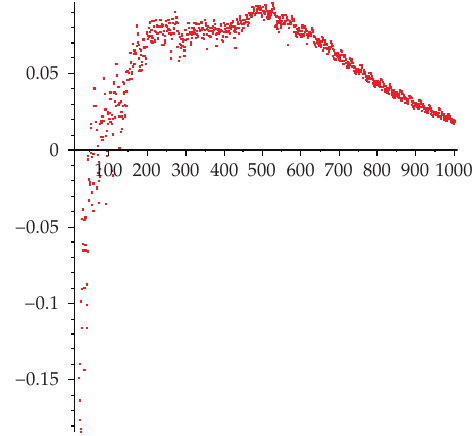
Figure 9: (cid:2) t,λ (cid:2) t (cid:3) /t (cid:3) the Lyapunov exponent in the deterministic case for d (cid:7) 0 .